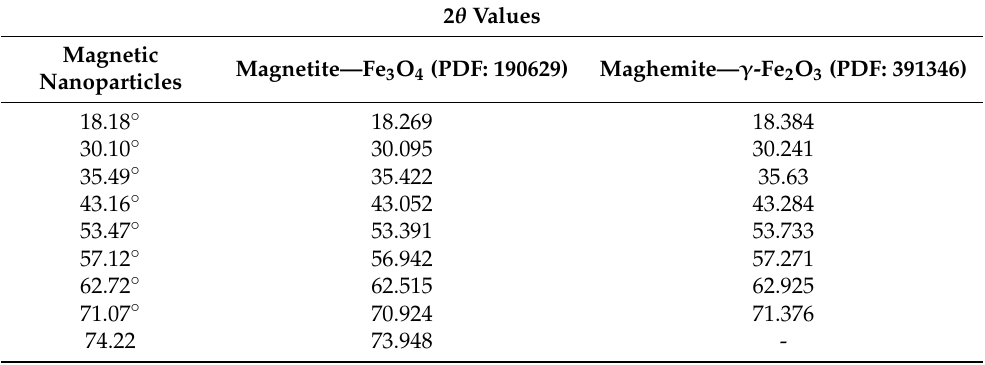
Table 2. The 2 θ values of the obtained MNPs as compared to 2 θ values of Fe 3 O 4 and γ -Fe 2 O 3 from the International Centre for Diffraction Data Powder Diffraction File.